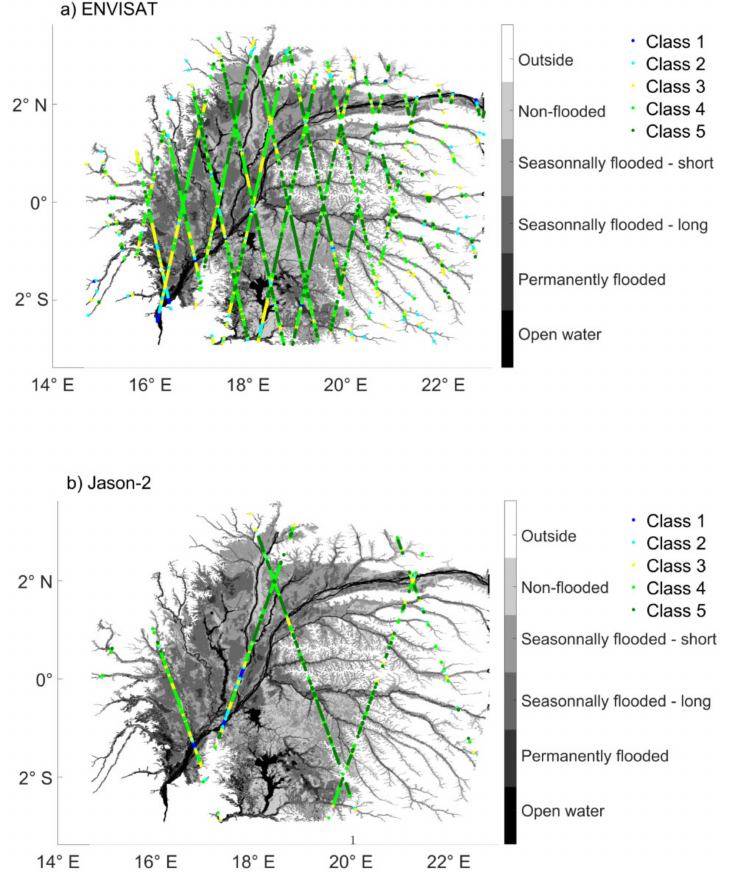
Figure 5. Spatial distribution of the backscattering classes (Ku band) from ( a ) ENVISAT and ( b ) Jason- 2 in the Cuvette Centrale of